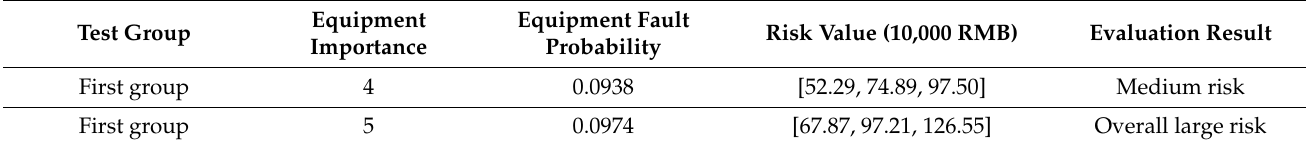
Table 13. Comparison of the evaluation results of different equipment importance.